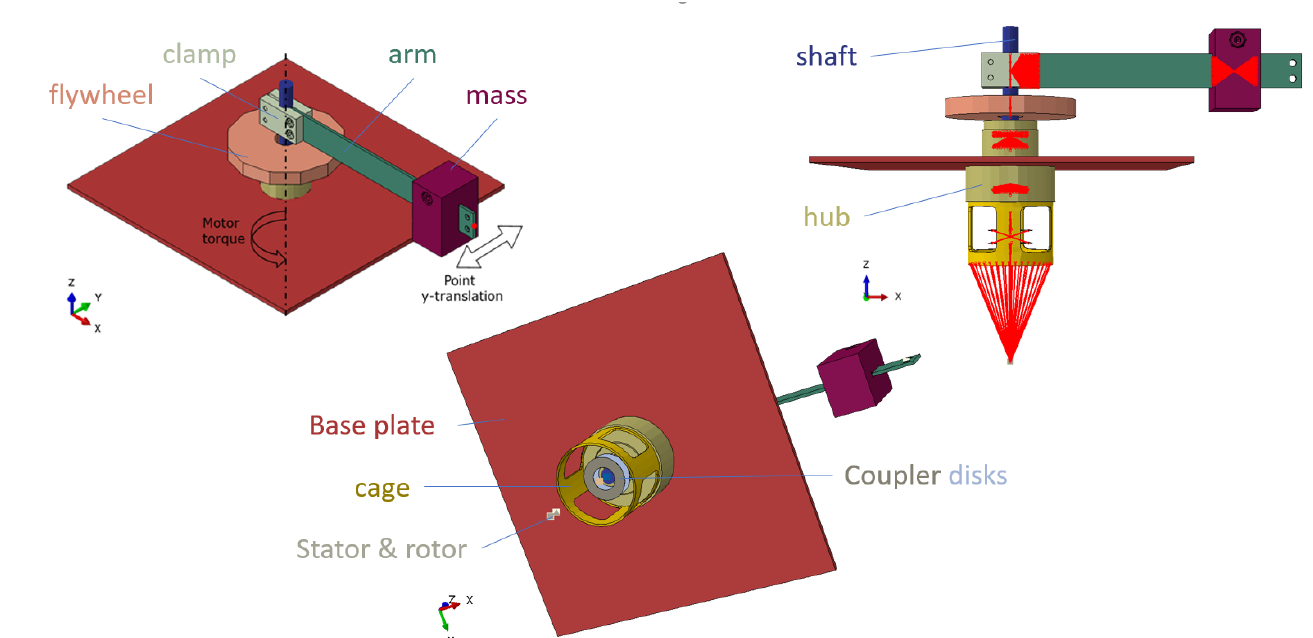
Figure 9. FEM model of the flexible manipulator: ( left ) input and output, ( right ) couplings, ( bottom ) bottom